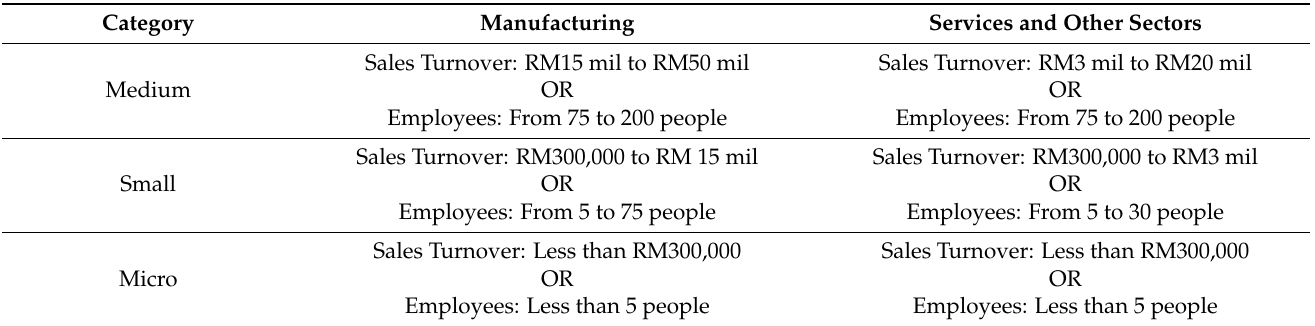
Table 1. Definition of SMEs in Malaysia. Adapted with permission from Ref. [19]. Copyright